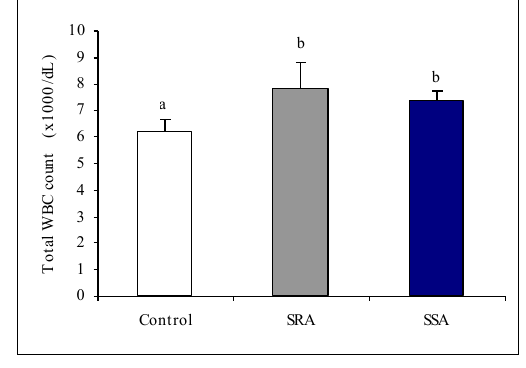
Fig. (4): Total WBC count among SSA (n=28) and SRA (n=27) patients. Values are (mean ± SEM). Non-identical superscripts (a, b) considered significant, P<0.05 analyzed by ANOVA.